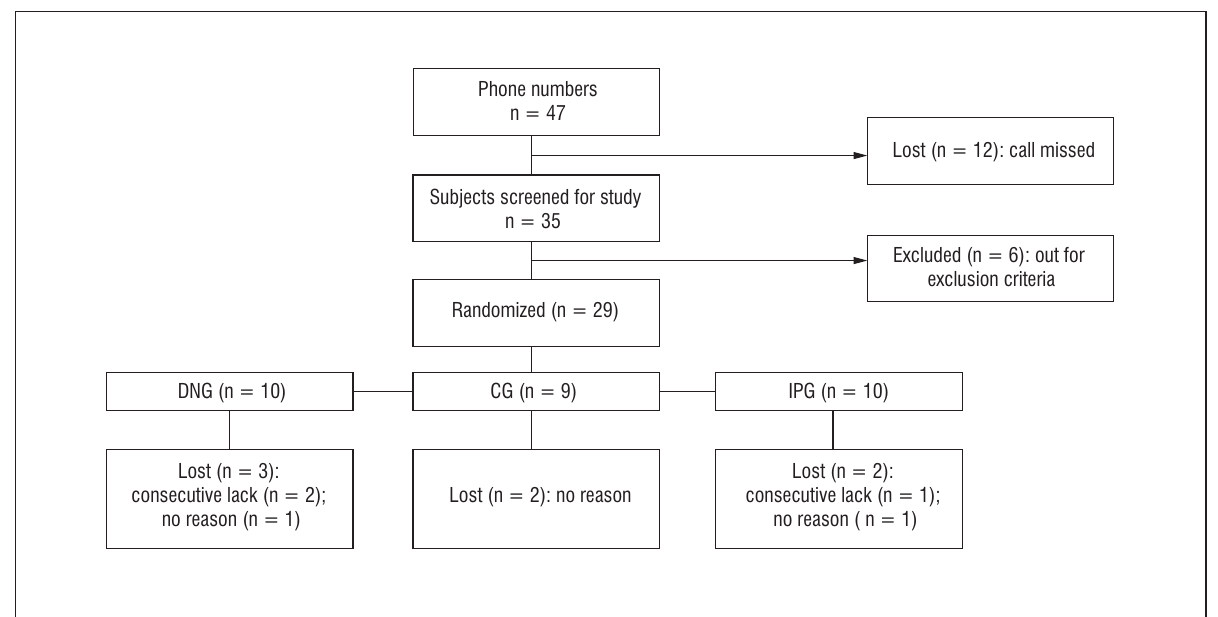
Figure 1 - Flow of the sample